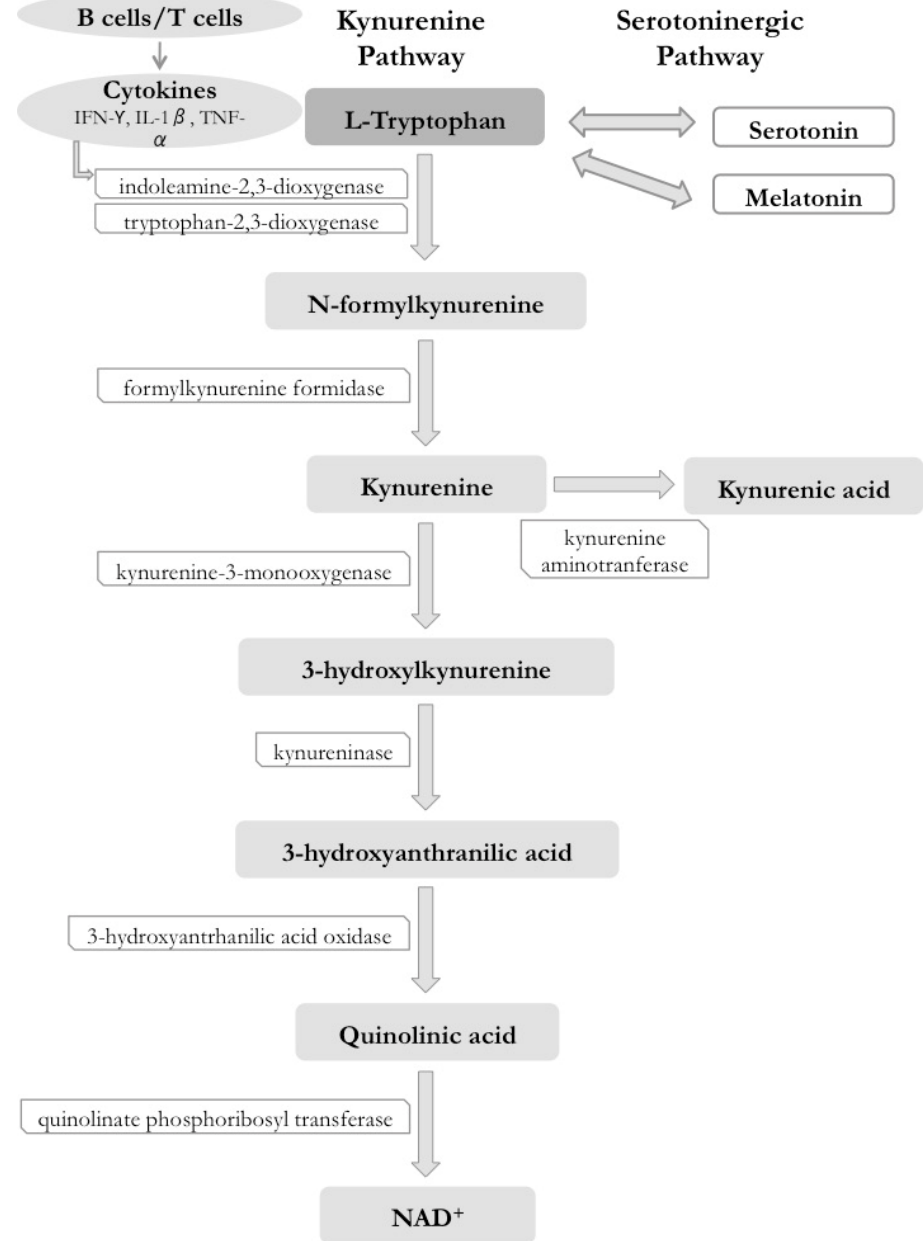
Figure 3. Kynurenine pathway (KP) and metabolites. Several of the metabolites have neuromodulatory effects [14,140–142]. The fine gray arrows indicate chemotactic and enzymatic effects, the thick gray arrows indicate the subsequent metabolite in the cascade, whereas the two-way gray arrows indicate the potential conversion of one molecule in the other, depending o demand and the subtract availability. IL-1 β is Interleukin -1beta and TNF- α is Tumor Necrosis Factor-alpha.